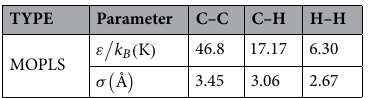
Table 1. The details of MOPLS model adopted in this study 47